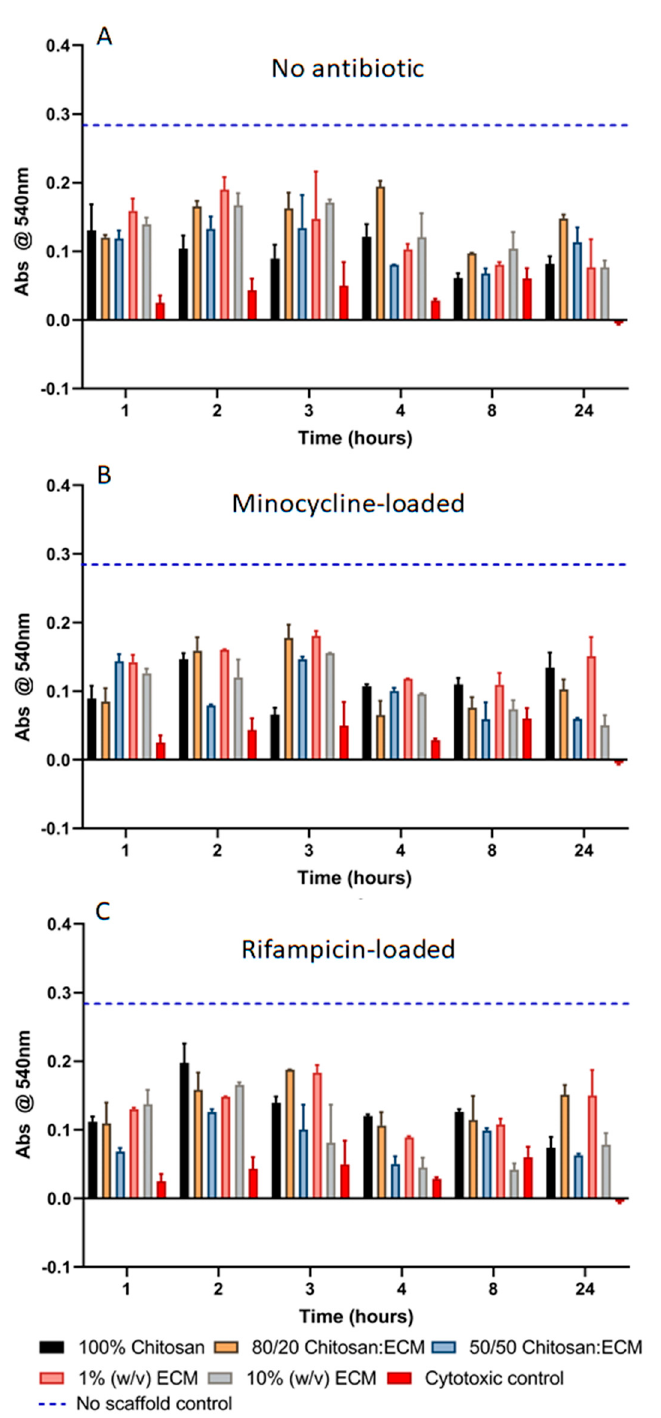
Figure 6. Graph showing the neutral red uptake by human microvascular endothelial cells exposed to supernatant samples from scaffold formulations with and without antibiotics. Supernatant samples were collected at 1, 2, 3, 4, 8 and 24 h. ( A ) Neutral red uptake of cells exposed to supernatant samples from scaffold formulations without antibiotic; ( B ) neutral red uptake of cells exposed to supernatant samples from scaffold formulations loaded with minocycline; ( C ) neutral red uptake of cells exposed to supernatant samples from scaffold formulations loaded with rifampicin. Blue line shows neutral red uptake of cells cultured in culture media alone (no scaffold control).